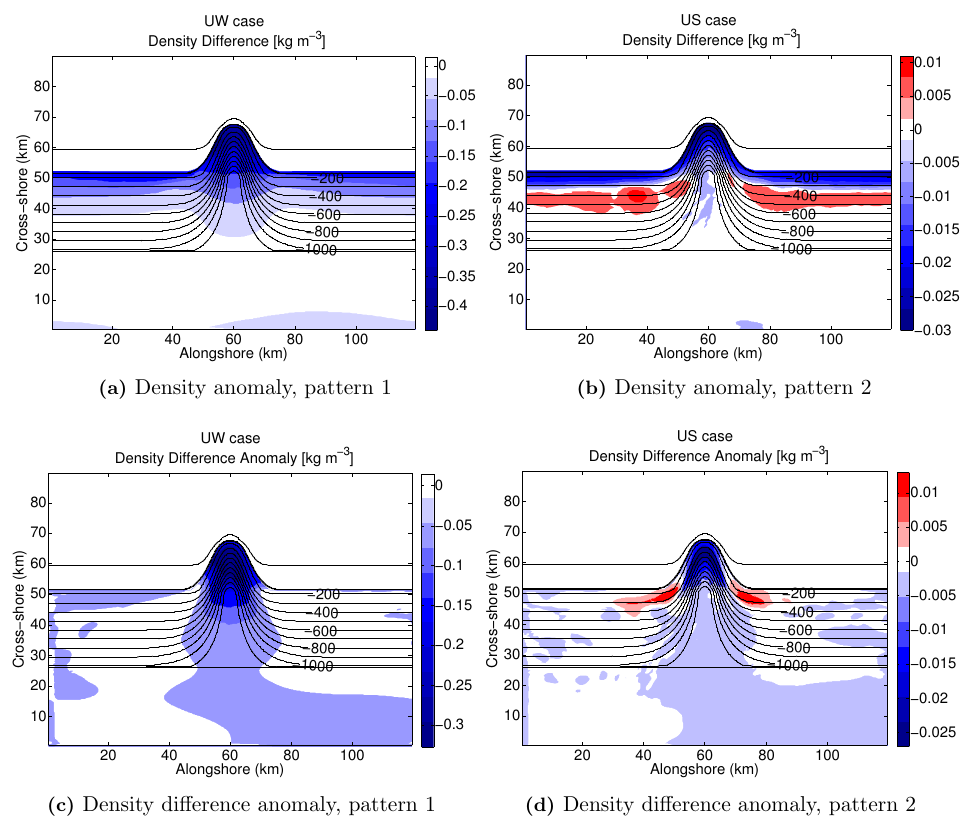
Figure 9. Density anomaly at shelf break depth (150m) in (a) simulation with pattern 1, i.e. negative density anomalies at all depths (UW), and (b) simulation with pattern 2, i.e positive density anomalies away from the canyon (US). Density difference anomaly at shelf break depth (150m) in (c) simulation with pattern 1, i.e. enhanced density advection everywhere in the model domain (UW), and (d) simulation with pattern 2, i.e. enhanced downwelling within the canyon and weaker downwelling near the canyon mouth (US). Anomalies are averaged over a period of 3 model days during the advection phase (model days 5–8). Table 8. Positive density and nitrate anomaly depth range for all model simulations based on advection-dominated phase average (model days 4–10). Pattern 1 anomalies had no positive values. Pattern 2 anomalies had positive values. Positive anomalies are included if their value is greater than 10% of the negative anomalies in the same horizontal